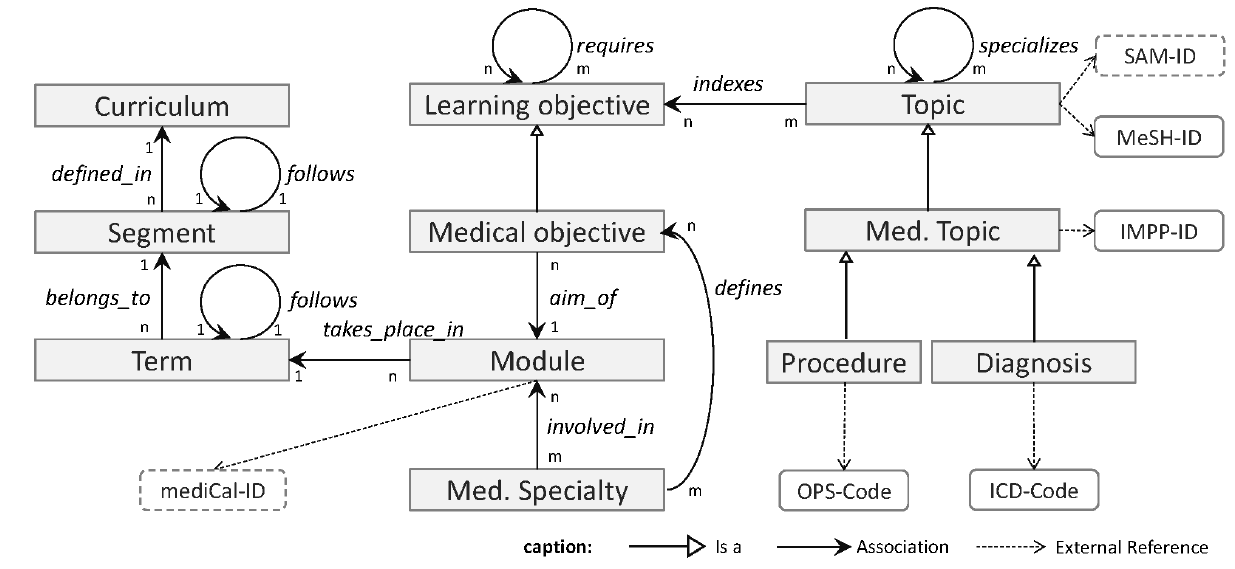
Figure 2. Core data model of ACLO-Web (grey boxes correspond to SMW categories, arrows correspond to SMW semantic relations; arrow subscripts (1-1, 1-n, n-m) correspond to one-to-one, one-to-many, and many-to-many relationship types, respectively; and boxes with rounded corners indicate references to external classification systems established by ID